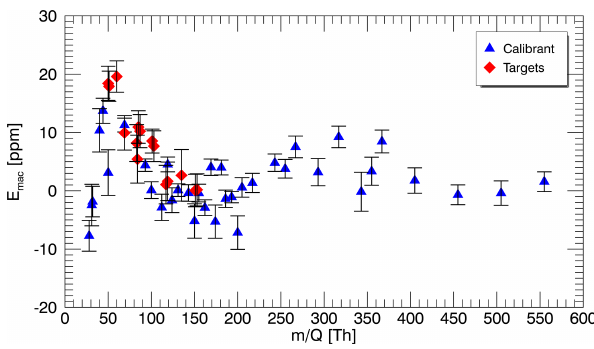
Figure 2. Mass resolving power over the whole mass range as determined for all mass axis calibration masses found in calibrant pulses during a measurement series as well as 15 target masses from analyte molecules. Error bars: 1-fold standard deviation of each mass over 44 individual